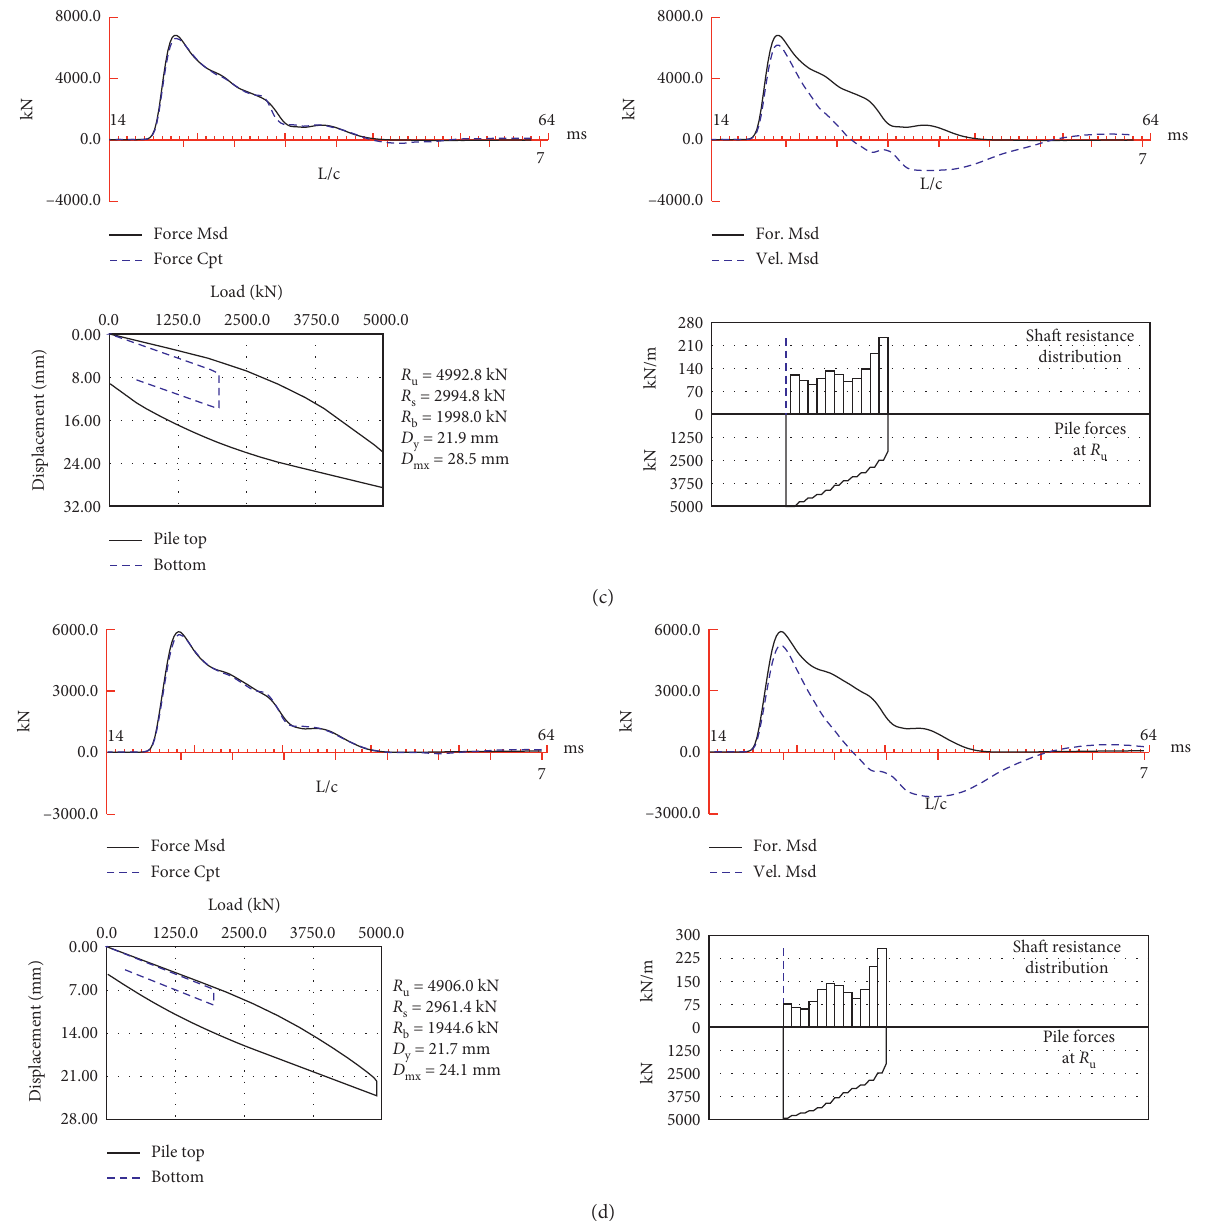
Figure 9: Results of high-strain curve fitting for test piles (at the soft rock bearing stratum site). (a) Pile #1. (b) Pile #3. (c) Pile #5. (d) Pile